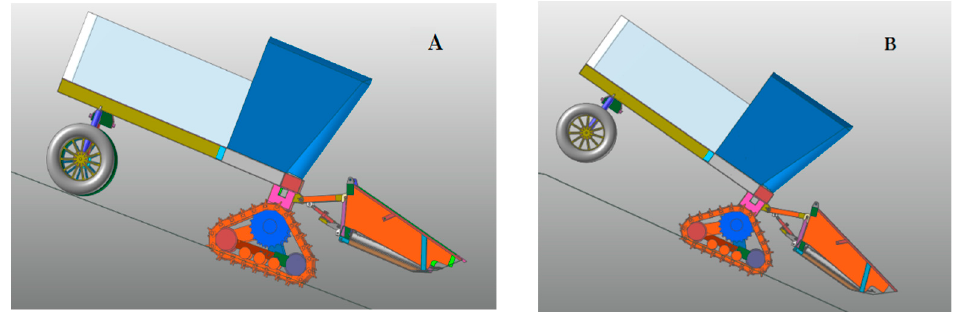
Figure 17. Downhill simulation. ( A ) Stable downhill state; ( B ) Unstable downhill state